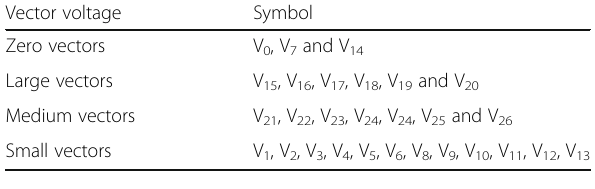
Table 3 Voltage vectors associated with switching states